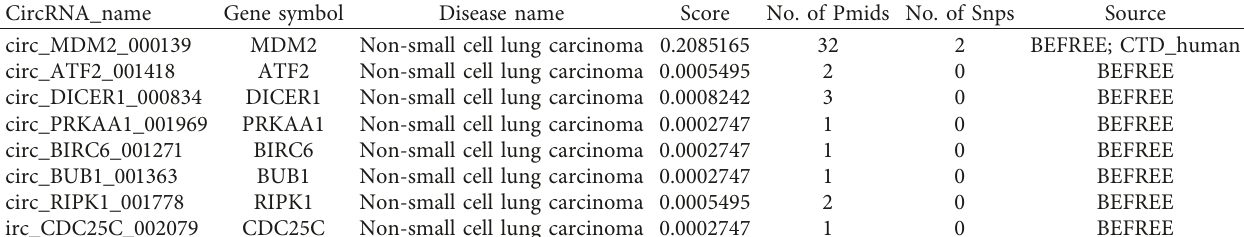
Table 5: The circular RNAs (circRNAs) correlated with non-small cell lung cancer.